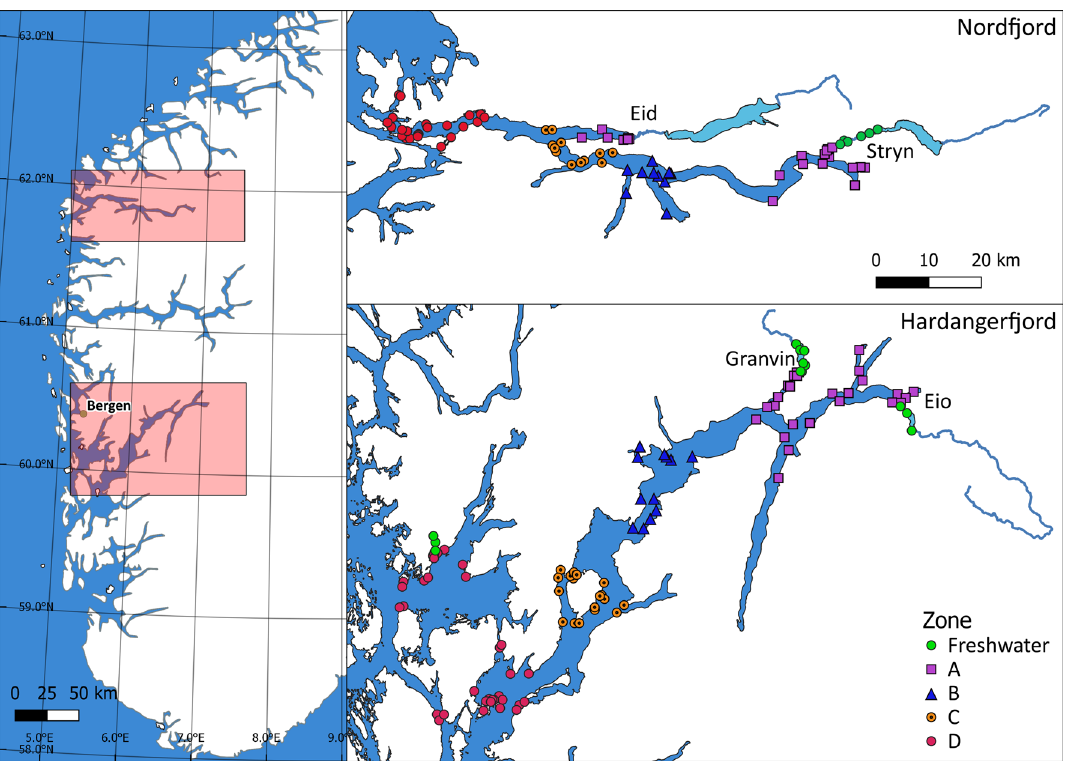
Figure 1. Map of study system showing locations of acoustic receivers along with the zone classification of these receivers. Figure produced using QGIS v3.10.2, (60 mg L −l tricaine methanesulphonate (MS-222)). After reaching full anaesthesia, all individuals were measured to the nearest mm (total length), weighed to the nearest 0.1 g and placed in a v-shaped surgical trough with a continuous anaesthetic flow over the gills for the entire procedure (40 mg L −l MS-222). A small fin clip of the pelvic fin was taken for DNA analyses. Acoustic tags were sterilized in ethanol, allowed to air dry, and inserted intraperitoneally through a small incision (~ 10 mm) slightly offset of the ventral line, about 2 cm behind the pectoral fin. The incision was closed with three interrupted double surgical knots using non-absorbent 4-0 monofilament suture and sealed with a tissue adhesive (monomeric n-butyl-2-cyanoacrylate). After the surgical procedure, the tagged smolts were kept in 60 L recovery tanks continuously refreshed with water until they reached full consciousness (1–2 min). The smolts were subsequently released near their respec- tive catch sites within four hours after tagging. The surgical protocol for implanting acoustic tags followed the general recommendations given by Mulcahy 37 and Cooke and Wagner 38 . The experimental protocol was approved by the Norwegian Animal Research Authority (ID 15471 and ID 12002) and the provincial government as per the Norwegian Regulation on Animal Experi- mentation 18.06.2015, § 6 and 12. The tagging permits specified a minimum tagging size of 12.5 cm. However, due to a communication error, 85 out of the 377 individuals tagged were below this threshold. We were not able to detect any difference in the performance of these individuals and those that were above the threshold (see “Discussion”). All personnel involved in the tagging and handling of fish were trained and familiar with FELASA guidelines, and the study was planned and conducted in accordance with ARRIVE guidelines 39 . Two different types of acoustic tags (ID-LP7 and D-LP7) were used, both manufactured by Thelma Biotel AS, Trondheim, Norway. Both transmit unique ID codes every 30–90 s and have a battery life of roughly 150 days, but D-LP7 also transmits depth data with a resolution of 0.2 m. ID-LP7 transmitted on the protocol R64K, now known as A69-1303, while D-LP7 transmitted on the protocols S64K and S256 in Hardangerfjord and Nordfjord, respectively. The transmitting range of these tags is highly dependent on the acoustic conditions in the environ- ment and can vary from 100 to 400 m. The tags that only transmitted ID were 7.3 mm in diameter and 17 mm long, with a weight in air of 1.8 g. The tags that also transmitted depth data were slightly longer with a length of 21.5 mm and a weight in air of 2.0 g. The mean tag burden across all tagged fish was 9.8% of body weight, with a standard deviation of 2.2%. In Nordfjord, 118 (134 mm ± 11.6; length ± SD) pre-smolts were tagged in the river Stryn in 2017. In 2018, sampling was extended to include the river Eid, such that 34 (129 mm ± 11.1) and 66 (131 mm ± 10.2) pre-smolts were tagged in the rivers Stryn and Eid, respectively. In Hardanger, 74 (137 mm ± 10.9) and 86 (141 ± 15.4) pre- smolts were tagged in Eio and Granvin, respectively (Table 1).